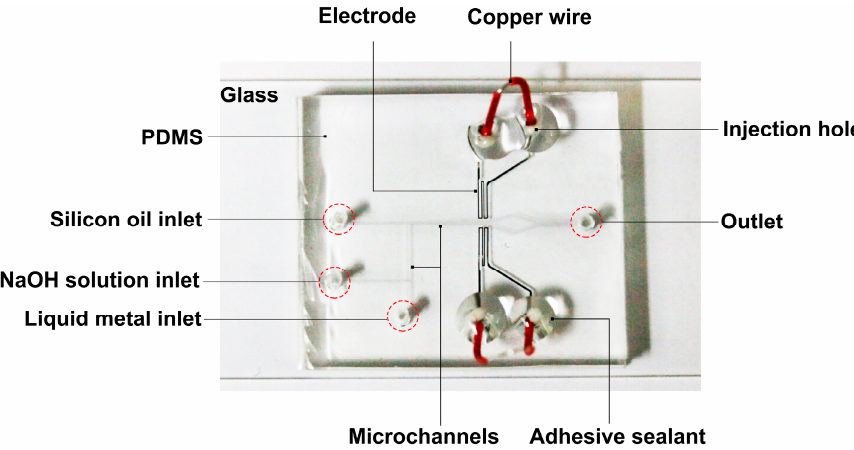
Figure 2. Optical photograph of a PDMS/glass microfluidic chip for liquid metal droplet generation and sorting by liquid metal electrodes.